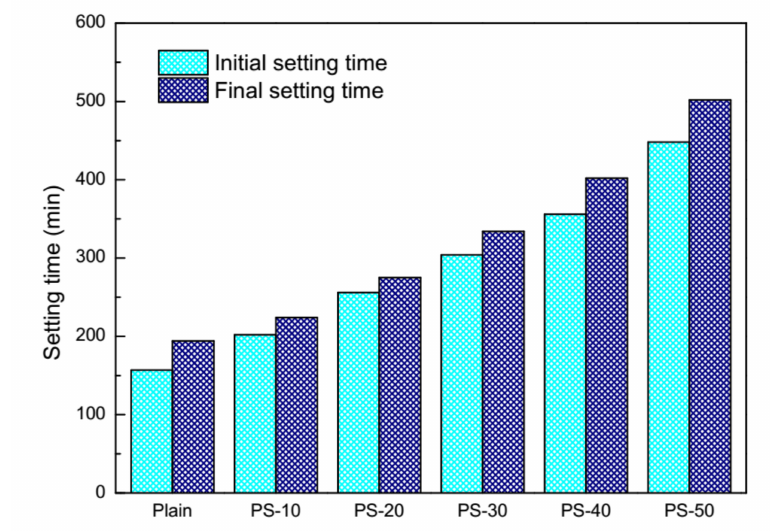
Figure 3. E ff ects of phosphorus slag on the setting